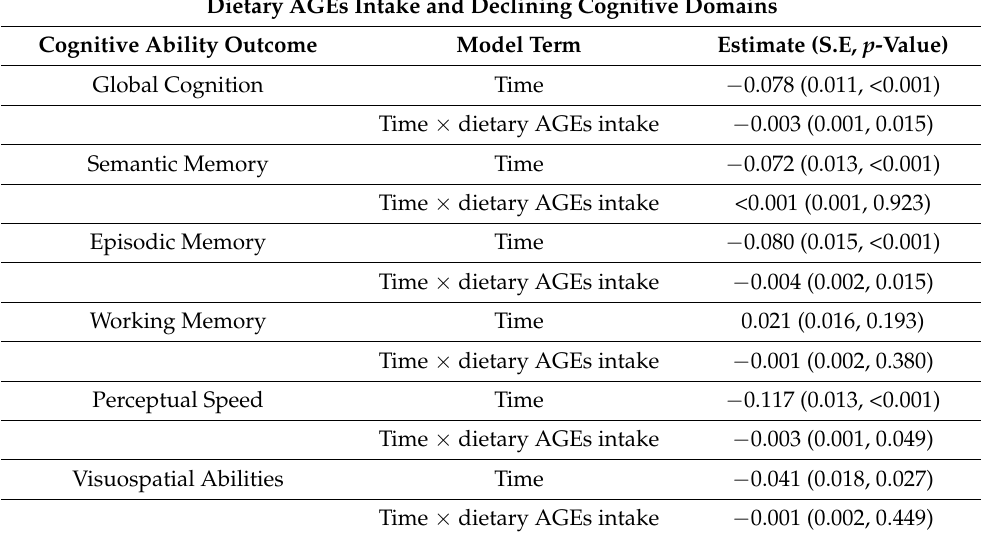
Table 3. Dietary AGEs intake and declining cognitive domains.